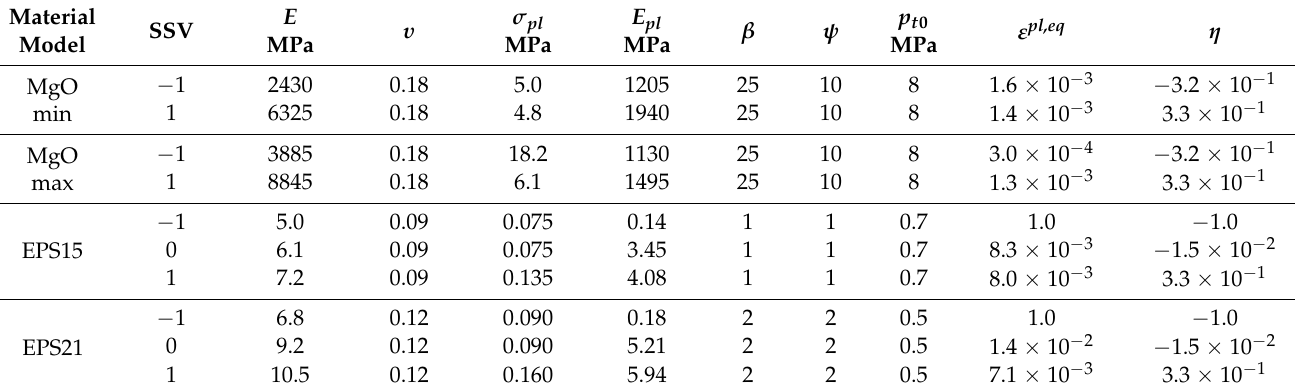
Table 2. Material parameter values used in FEA